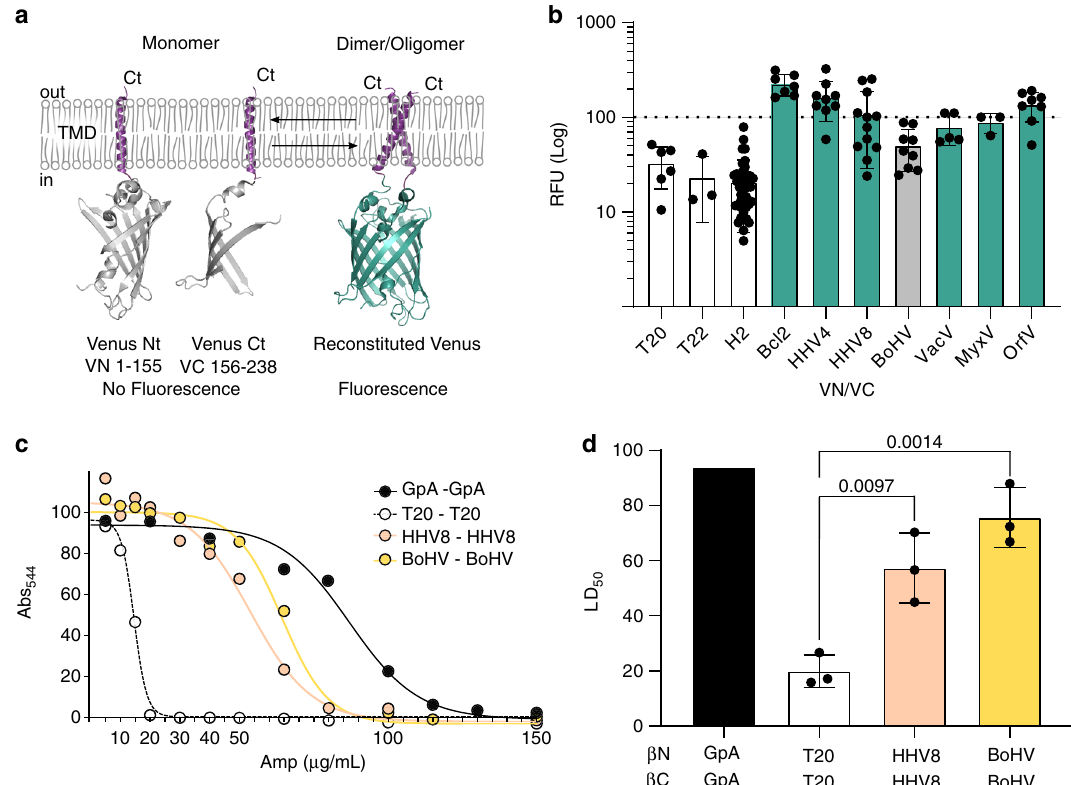
Fig. 2 Homo-oligomerization in biological membranes. a A schematic representation of the Bimolecular Fluorescent Complementation (BiFC) assay. The position of the Nt and Ct ends and the TMDs included in the constructs are indicated. The residues included in each VFP fragment are indicated below the protein representation. b Relative fl uorescence units (RFU) of each tested homo-oligomer in the BiFC assay. The mean and standard deviation of at least three independent experiments are represented ( n values 6, 3, 37, 9, 9, 12, 9, 5, 3, 9, respectively). The individual value of each experiment is represented by a solid dot. The VN-GpA/VC-GpA homodimer, used as a positive control and to normalize values across experiments, is represented by a dotted line. The T20, T22, and Lep H2 TMDs were included as negative controls (white bars). Those homo-oligomer that produced fl uorescence levels signi fi cantly higher than the T20 TMD homo-oligomer (two-tailed homoscedastic t -test) are highlighted in green, and those that did not are shown in light gray. c Representative examples of dose – response curves used to calculate LD 50 values in the BlaTM assay. The TMD homodimer of GpA was used as a positive control (black), while the T20 TMD was used as a negative control (white). d BlaTM calculated mean and standard deviation LD 50 of at least three independent experiments ( n = 3). The individual value of each experiment is represented by a solid dot. The β N-GpA/ β C-GpA homodimer was used as a positive control (black bar). The level of signi fi cance ( p -value, two-tailed homoscedastic t -test) when comparing T20 (white bar) vs HHV8 (pink bar) or BoHV (yellow bar) homo-oligomers is shown above the